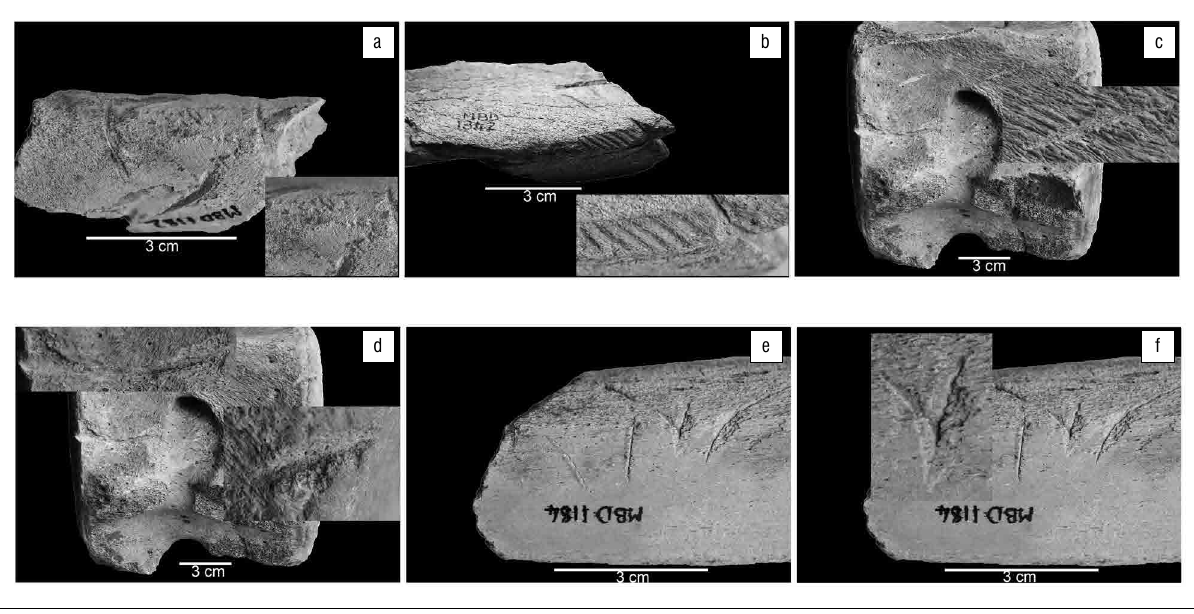
Figure 4: (a) B3/B4 bite mark caused by unserrated teeth scraping across the mandible fragment (SAMPQMB-D-1182) (inset close-up of damage). (b) CF3 bite mark on a cranial fragment (SAMPQMB-D-1342. (c) CF1a bite mark on a caudal vertebra centrum (SAMPQMB-D-71) (inset close-up). (d) CF2 bite marks on caudal vertebra centrum (SAMPQMB-D-71) (inset shows close-up of damage). (e) CF1a bite marks on a rib fragment. (f) Unusual bite mark caused by serrated teeth forming an upside down ‘V’ (SAMPQMB-D-1184) (inset close-up of